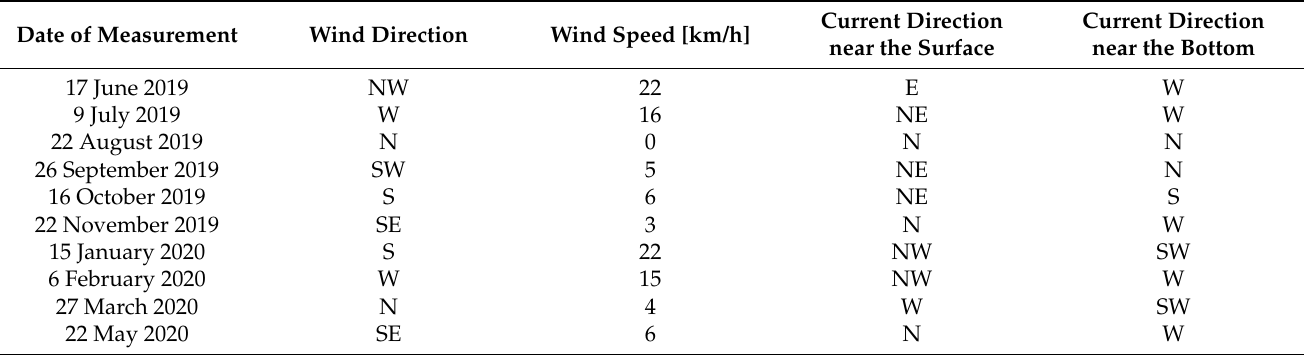
Table 3. Wind directions and speeds, and surface and bottom currents directions measured at point 61 during the field survey.